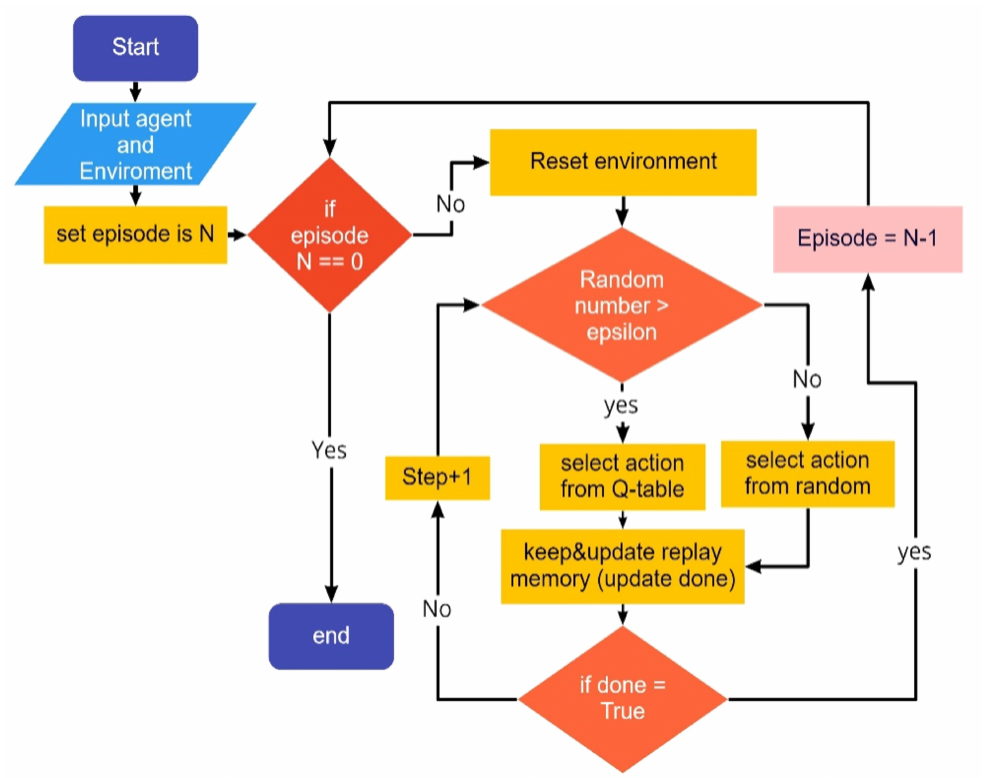
Figure 6. Process to select the action in DQN model.